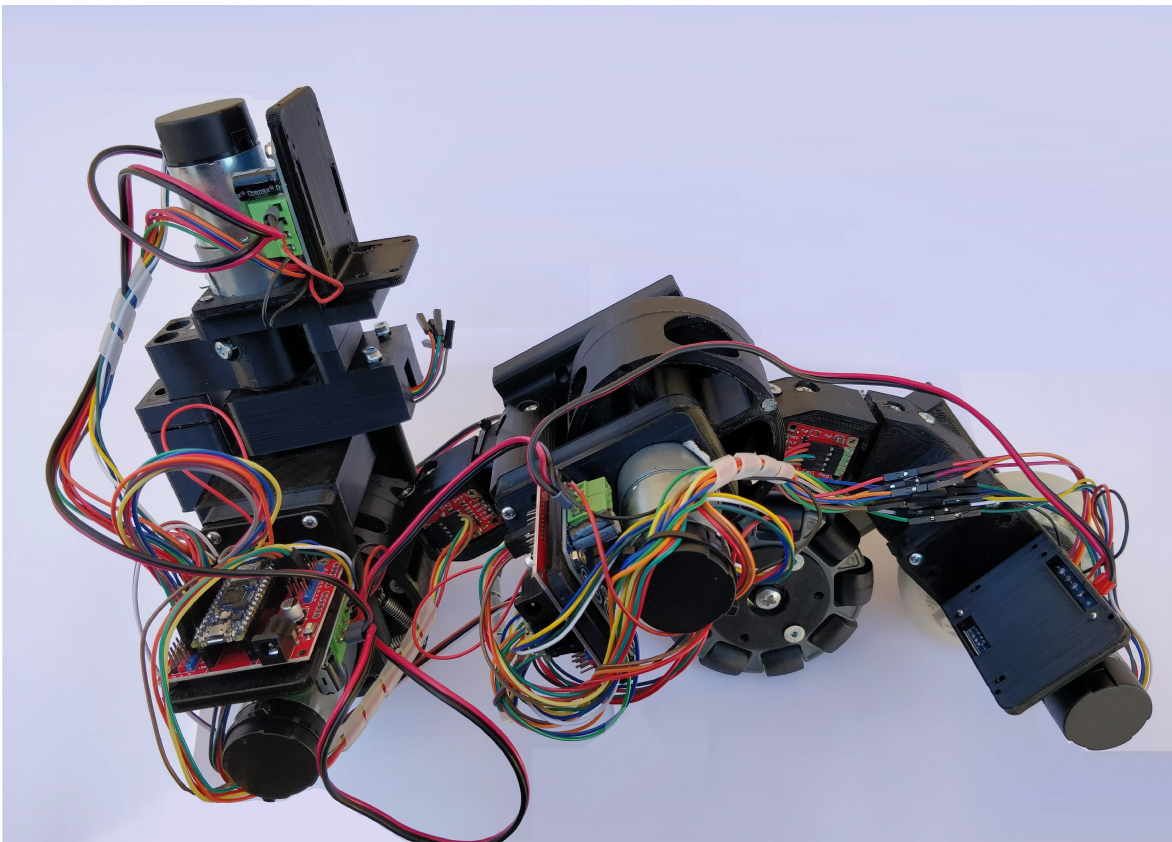
Figure 5. Developed leg prototype